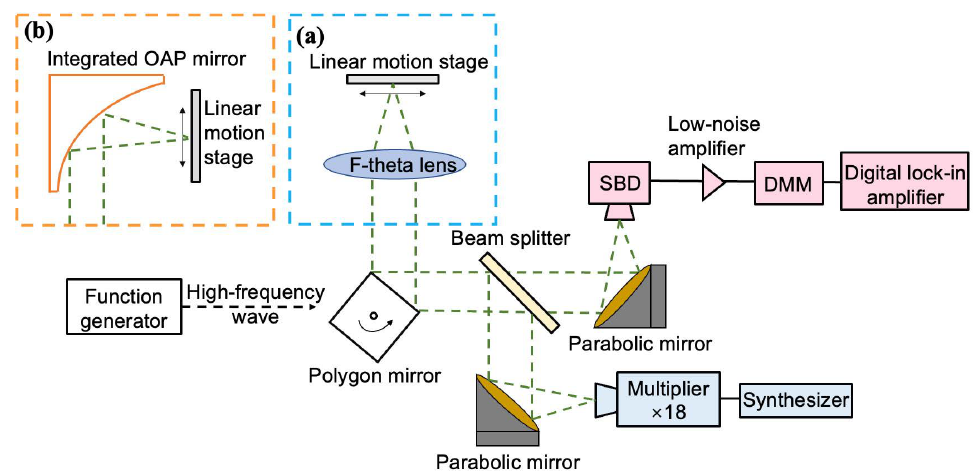
Figure 2. Block diagram of the imaging system. ( a ) Focusing element used in high-speed imaging system. ( b ) Focusing element used in the imaging system with enhanced focal depth. (SBD: Schottky barrier diode. DMM: digital multimeter.).